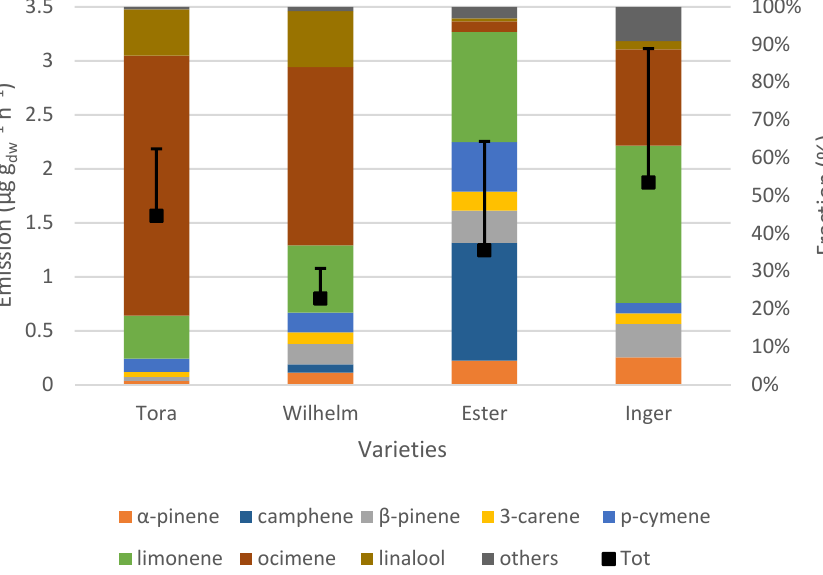
Figure 3. Total MT emissions (black square, µg g dw − 1 h − 1 , mean + standard deviation, n = 52–104) and the contribution from each MT for the different varieties. Others includes d-phellandrene, terpinolene, γ -terpinene and one unknown compound.